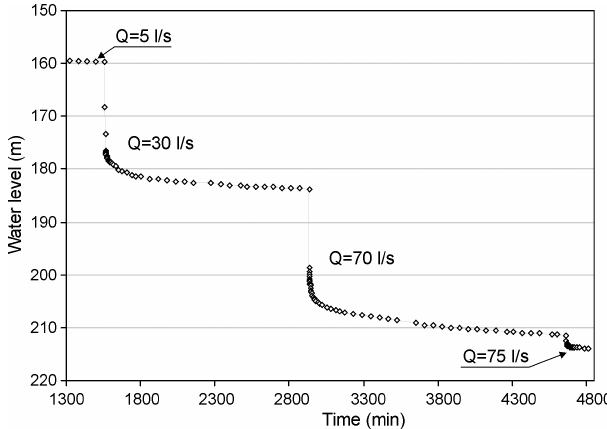
Figure 6. Water level versus time during the step-drawdown pump- ing test in the case